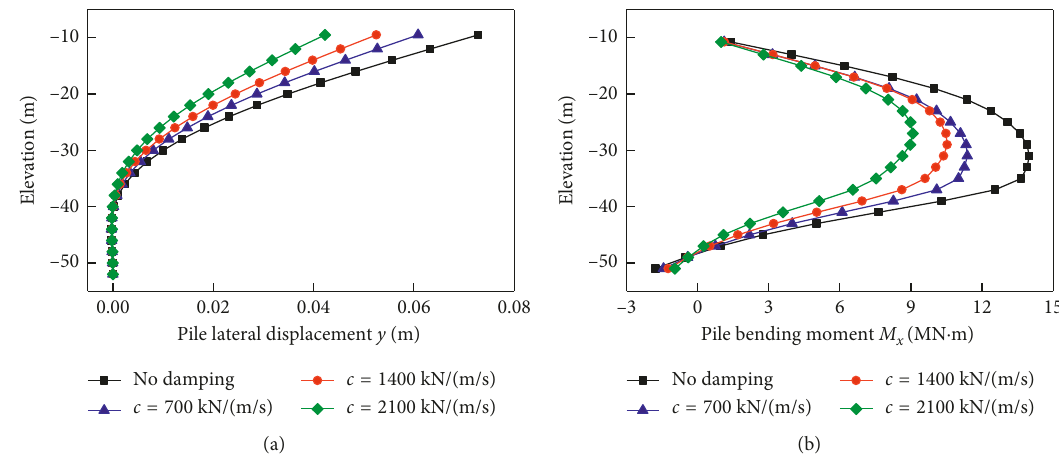
Figure 12: 5 th row pile responses for various soil damping. (a) Pile lateral displacement y in the 5 th row. (b) Pile bending moment M 5 th row.